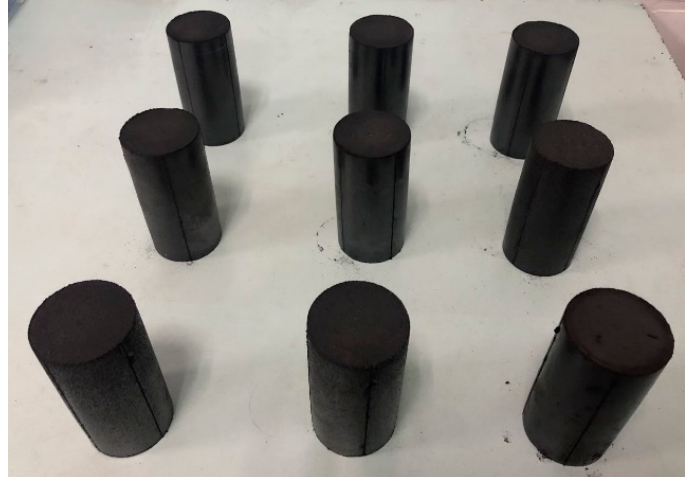
Figure 1. Briquette specimens.